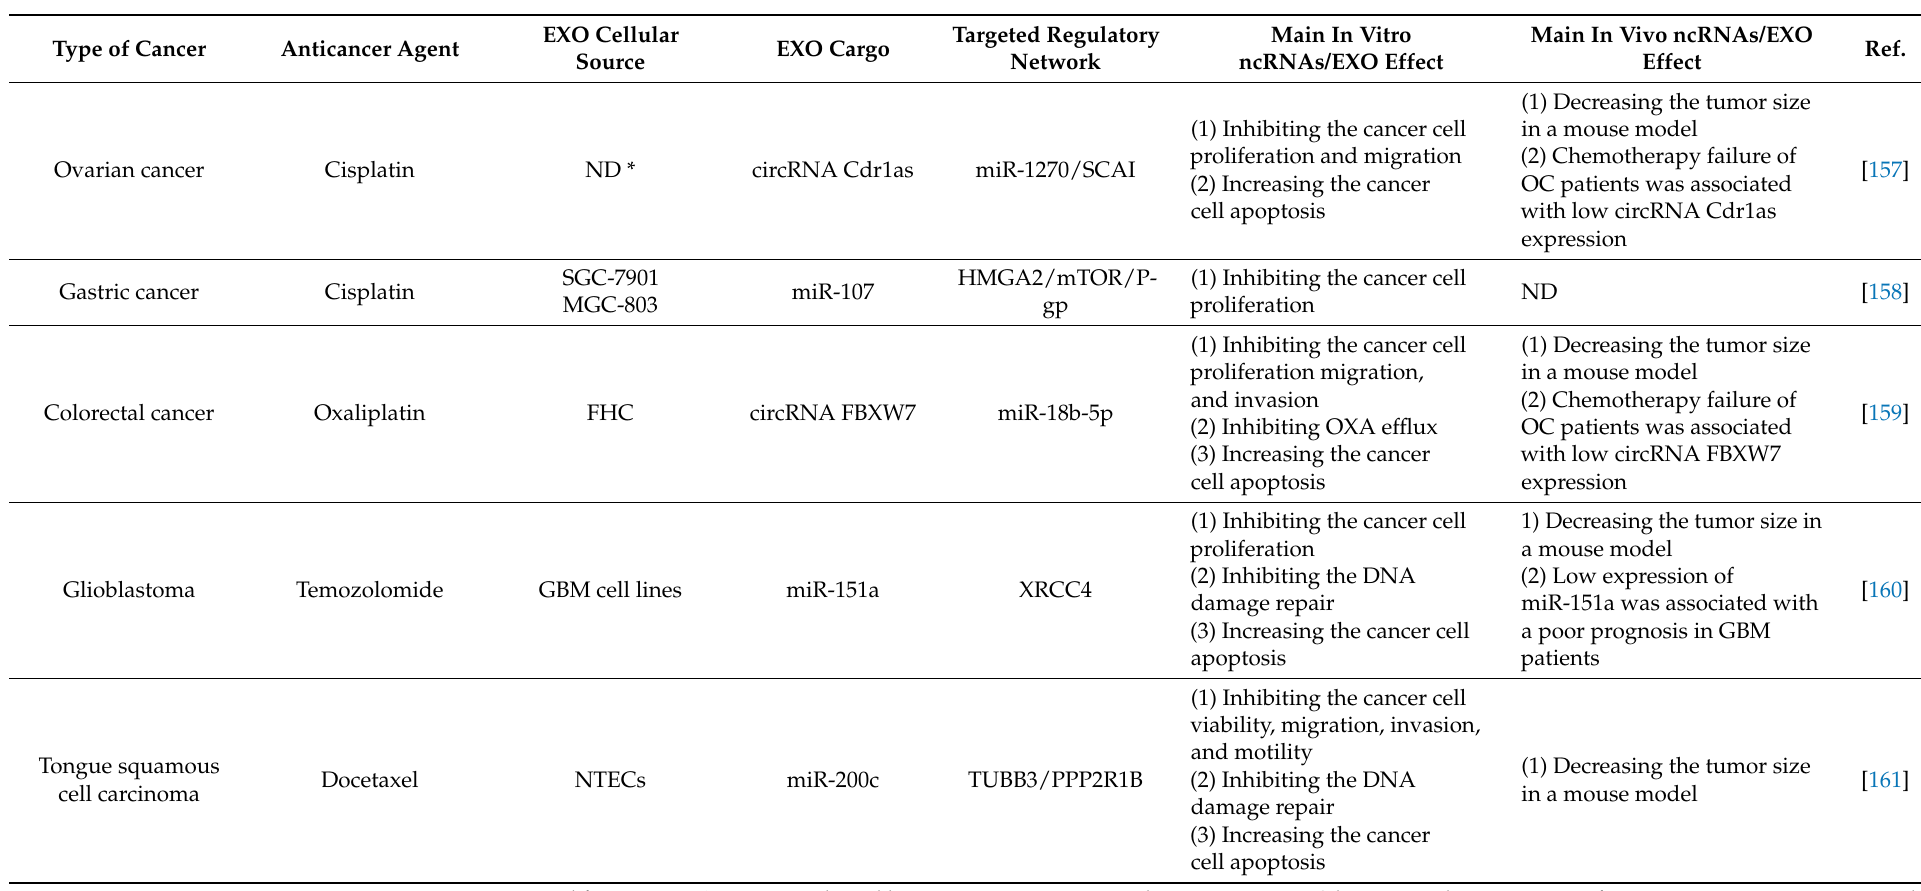
Table 4. Detailed analysis of exosomal non-coding RNAs (ncRNAs) mediated sensitivity to different types of chemotherapeutic agents in divergent types of